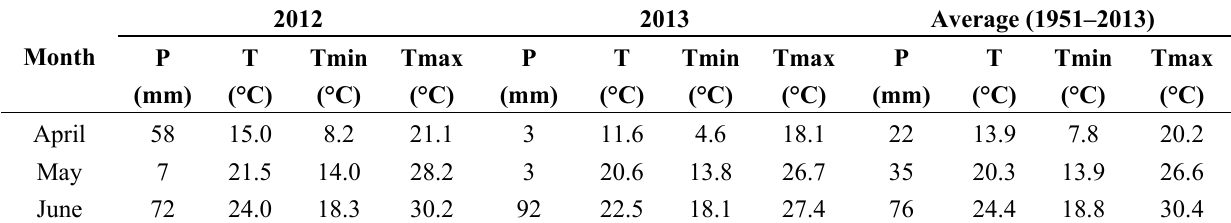
Figure 1. The location of the experimental station of the China Institute of Water Resources and Hydropower Research in the North China Plain is marked with a black dot. Table 1. Monthly precipitation, average, minimum and maximum air temperatures ( P , T , T min and T max , respectively) during the growing period (April–June) of experimental years 2012 and 2013 and long term averages (1951–2013) for the growth stages of winter